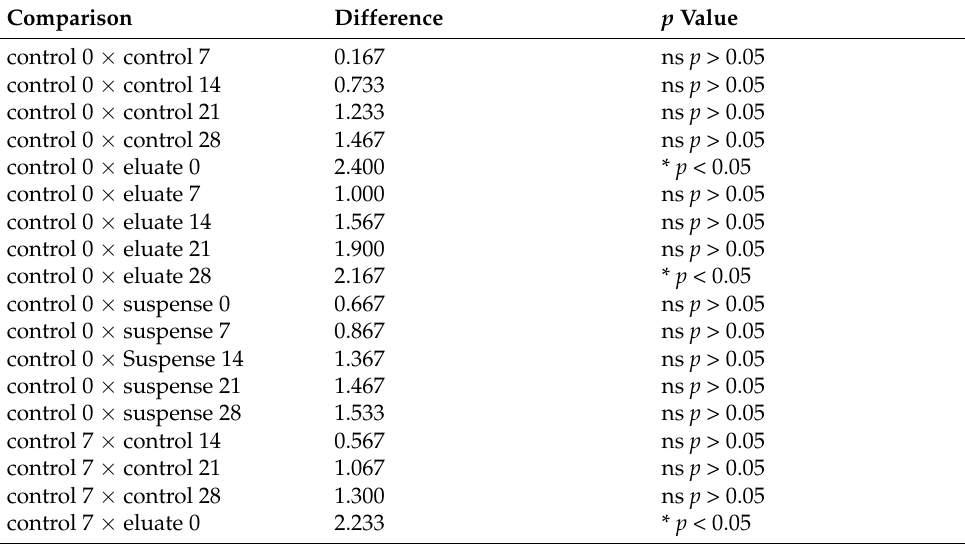
Figure 4. Rate of toxicity (%) during 7, 14, 21 and 28 days of exposure (the data were calculated according to Formula (3)). Table 2. Results of the statistical analysis. One-way analysis of variance (ANOVA) with the GraphPad InStat software was used (InStat version 3, San Diego, CA, USA). The multiple-comparison Tukey– Kramer test was performed at a 0.05 significance